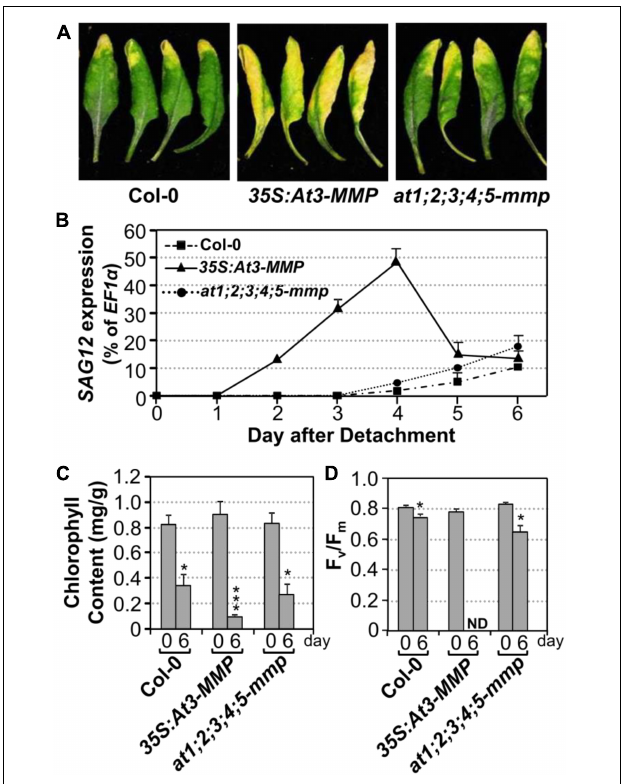
FIGURE 6 | Constitutive overexpression of At3-MMP leads to leaf senescence under continuous light. (A) Fully expanded leaves from 4-week-old soil-grown plants were detached and their petioles were inserted into 0.6% agar medium. Photos were taken after detachment 6 days. (B) RT-qPCR analysis of the transcript levels of SAG12 in the leaves of plants shown in (A) at indicated times. The expression of EF1 α was used as an internal reference. Values are means ± SD, n = 3. (C,D) Chlorophyll content (C) and F v /F m (D) in leaves shown in (A) . Values are means ± SD, n = 10. ND, not detectable. Asterisks indicate a significant difference (* P < 0.05, *** P ≤